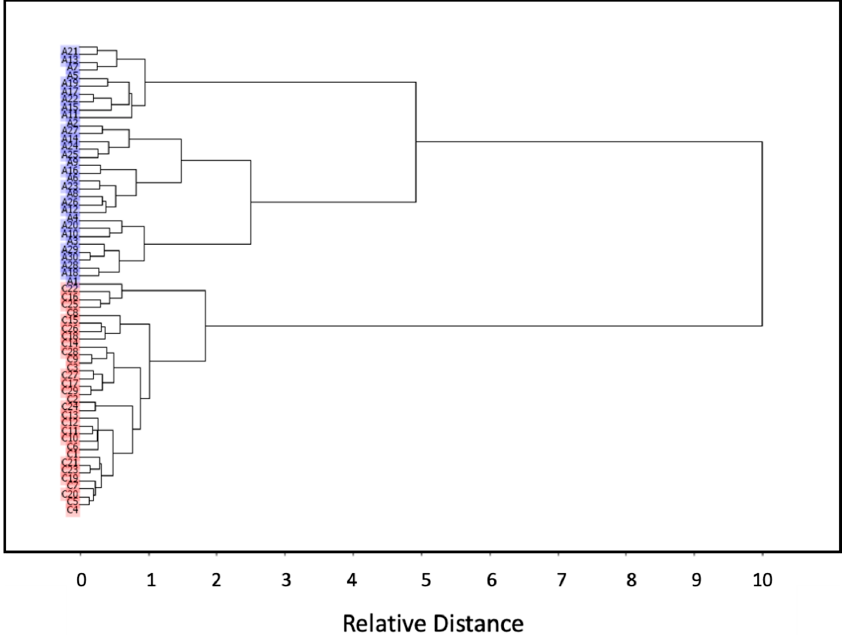
Figure 1. Average IR spectra of ASD (A-AVERAGE; thick blue line) and control (C-AVERAGE; thick red line) groups’ blood serum samples (3700–2400 and 1800–900 cm − 1 regions). Thin lines account for the standard deviations.